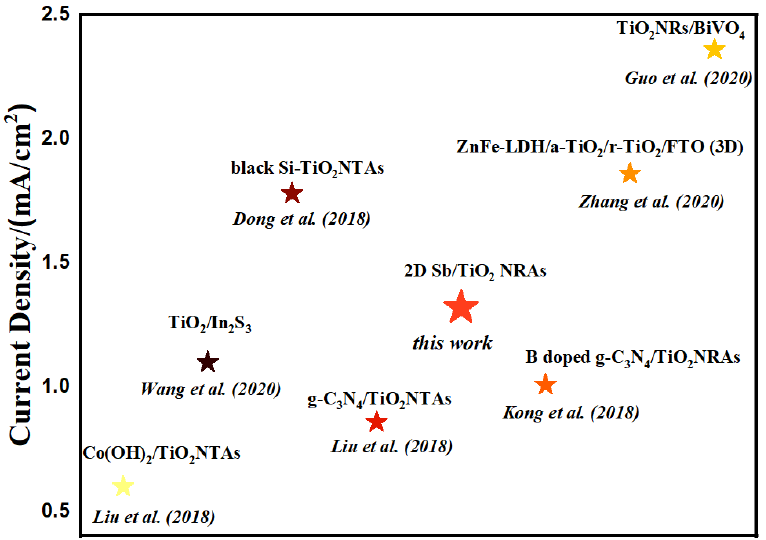
Figure 7. Comparison chart demonstrating the photocurrent density of previous works and this work. Each photocurrent density was obtained at 1.23 V vs. RHE [23,58–63].